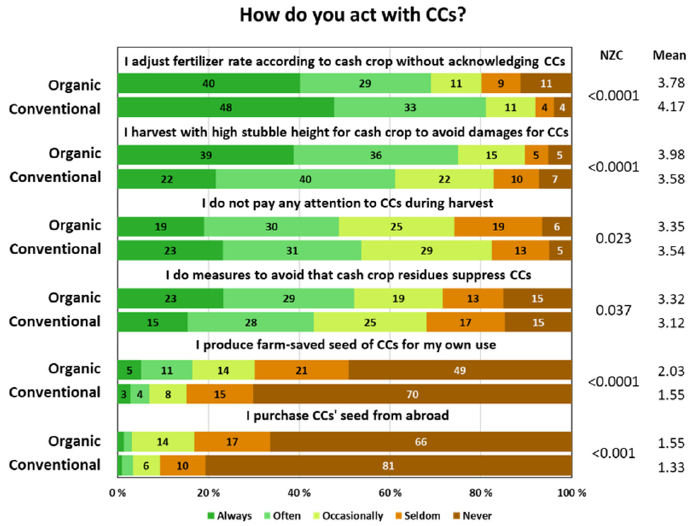
Figure 10. The distribution of farmers’ answers (N = 1130) depending on the farming system (NZC, nonzero correlation; CCs, cover crops).